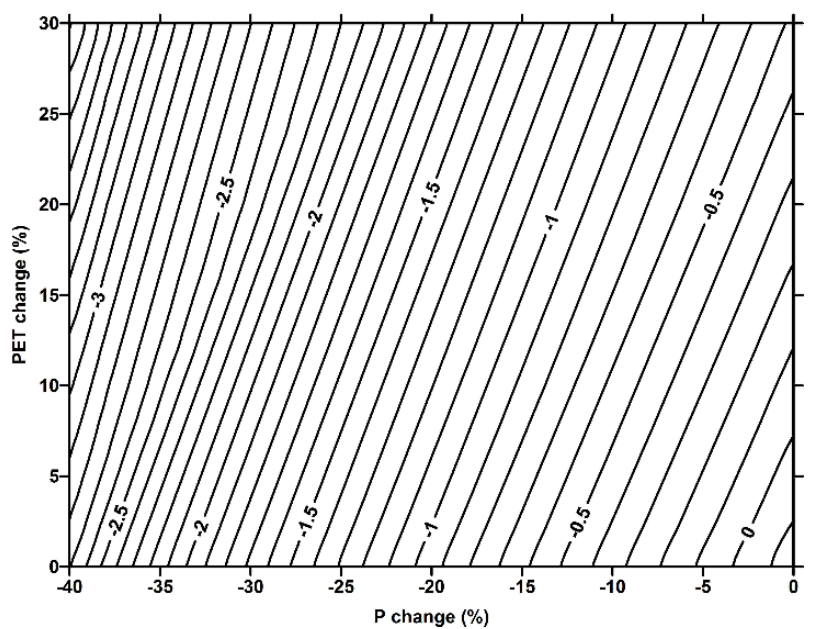
Figure 6. Anticipated Streamflow Drought Index ( SDI ) for the upper Diyala example basin regarding a wide range of climatic scenarios for precipitation ( P ) and potential evapotranspiration ( PET